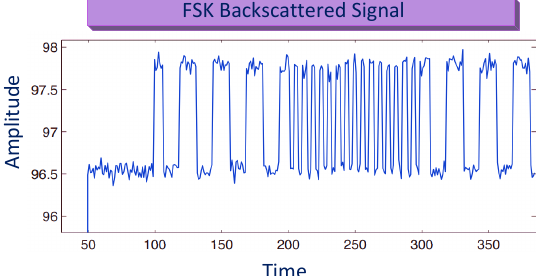
Figure 20. Frequency shift keying (FSK) for BackCom.